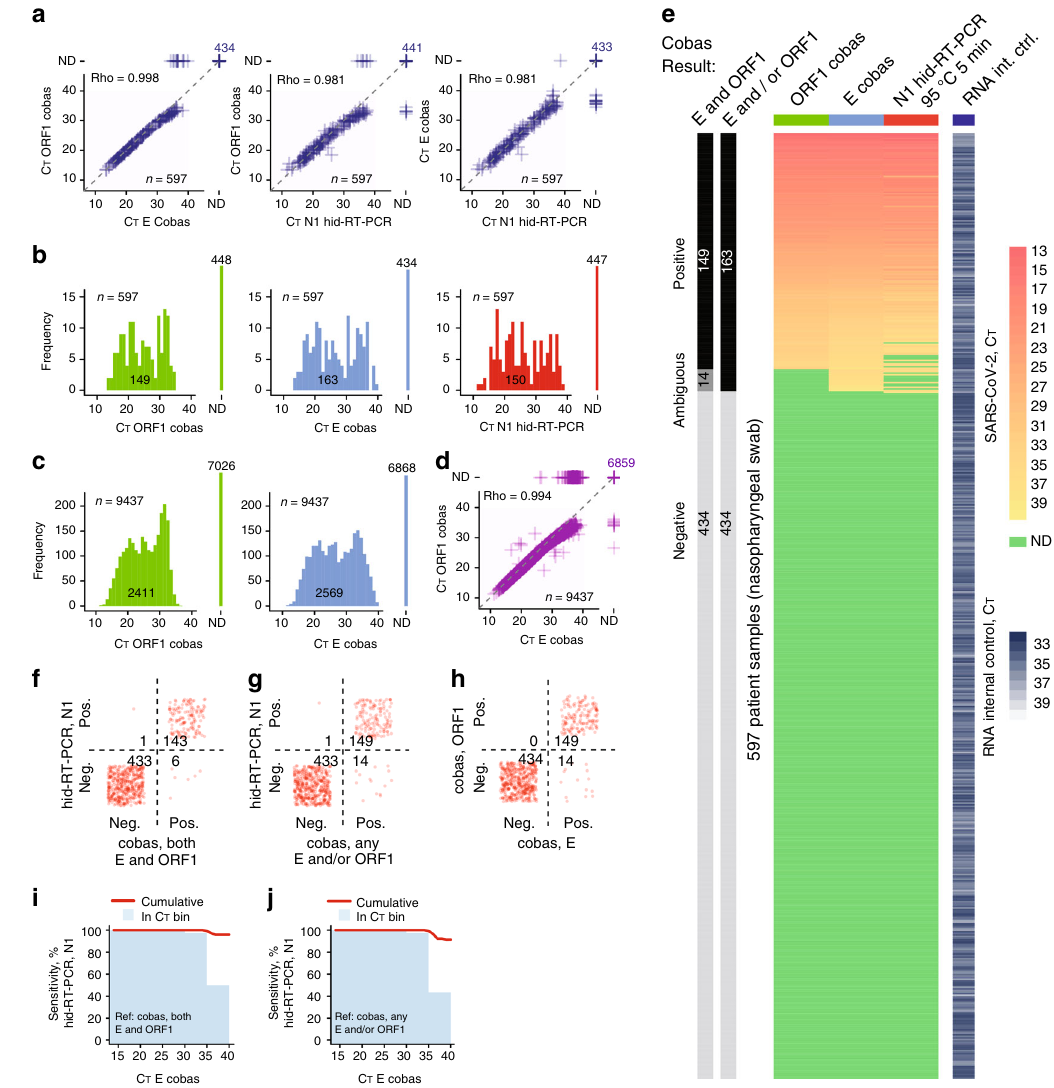
Fig. 5 Validation of SARS-CoV-2 hid-RT-PCR. a Scatter plots of C T values from clinical diagnostics performed on the Roche Diagnostics cobas 6800 ( y -axis) and hid-RT-PCR ( x -axis) for 597 nasopharyngeal swab samples, shown for different primer-probe set comparisons. Rho indicates Spearman correlation of positive samples. ND: not detected. b Histograms of C T values from 597 paired nasopharyngeal swab samples shown for the following primer-probe sets and conditions: cobas ORF1, cobas E, and hid-RT-PCR N1. ND: not detected. c Histograms of C T values from 9437 clinical samples analysed on a cobas 6800, show for ORF1 (left) and E (right). d Scatter plots of C T values from 9437 clinical samples analysed on a cobas 6800. Rho indicates Spearman correlation of positive samples. ND: not detected. e Heatmap of C T values from diagnostics performed on 597 clinical nasopharyngeal swab samples using the cobas 6800 (ORF1 and E primer-probe sets) and hid-RT-PCR (N1). The bars to the left indicate the clinical call from the cobas diagnostics, considering detection either in both or only one (any) primer-probe set for the diagnostic call. f – h Confusion matrix of diagnostic call from cobas 6000 and hid-RT-PCR (N1) for the data shown in ( e ). i Percent sensitivity of hid-RT-PCR (N1) using cobas ORF1 and E primer-probe sets as reference, shown as a function of C T threshold for the same sample as detected by the cobas primer-probe set E. The red lines denote the cumulative sensitivity below the given C T threshold and the bars denote the sensitivity in 5-C T bins. j Same as ( i ) but using cobas ORF1 and/or E primer-probe sets